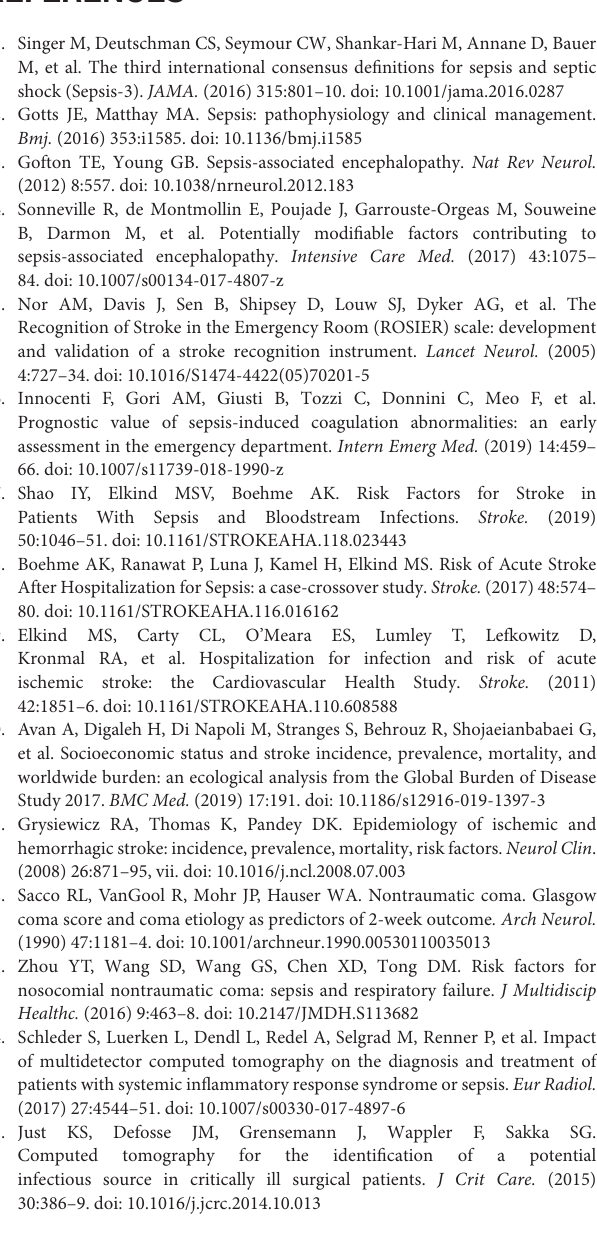
Supplementary Figure 1 | Different cerebrovascular events identified by non- contrast cCT. Ischemic stroke in the left posterior middle cerebral artery territory (A) ; large intracerebral hemorrhage of the right parieto-occipital lobe (B) ; left frontal